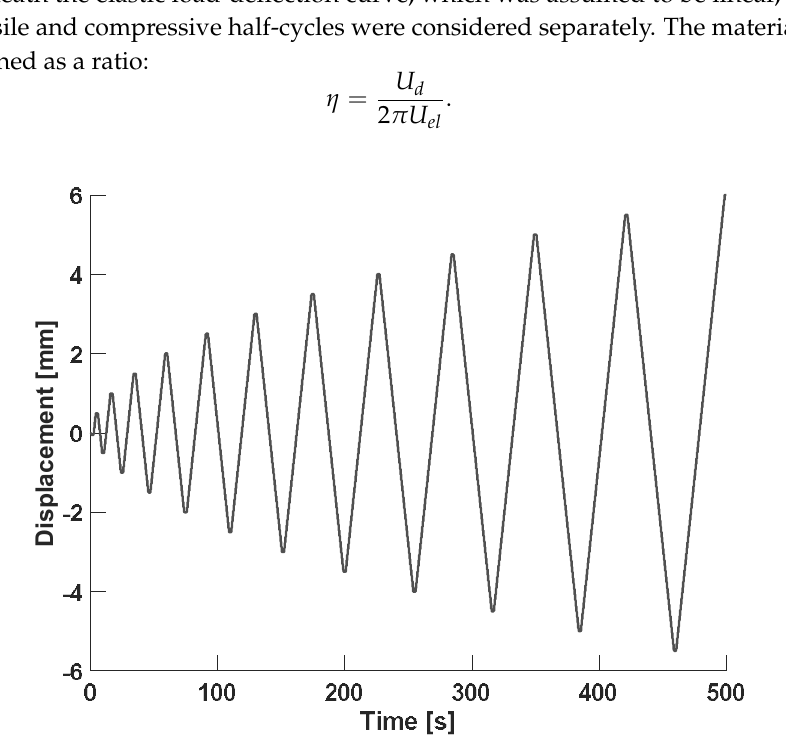
Figure 12. Displacement vs. time function used in ramped cyclic test. The crosshead speed is ±0.3 mm/s.